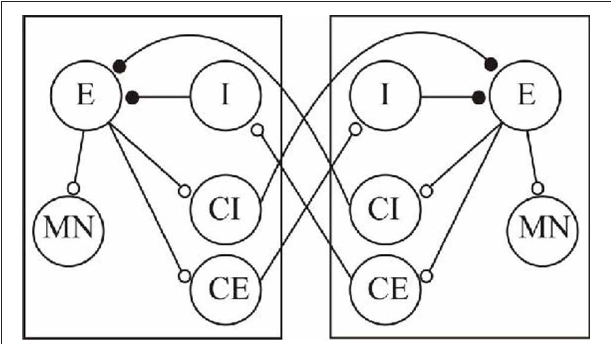
FIGURE 1 | A simplified scheme of a basic organization of spinal cord locomotor networks. The two boxes represent antagonistic networks (“half-centers” that control, for example, activity on the left and right sides of the body). The circles represent neuronal populations, and the lines synaptic connections. The small open circles indicate excitatory (glutamatergic) synaptic connections, the filled circles inhibitory (glycinergic) connections. E, excitatory interneuron; MN, motor neuron; I, inhibitory interneuron; CI, crossing inhibitory interneuron; CE, crossing excitatory